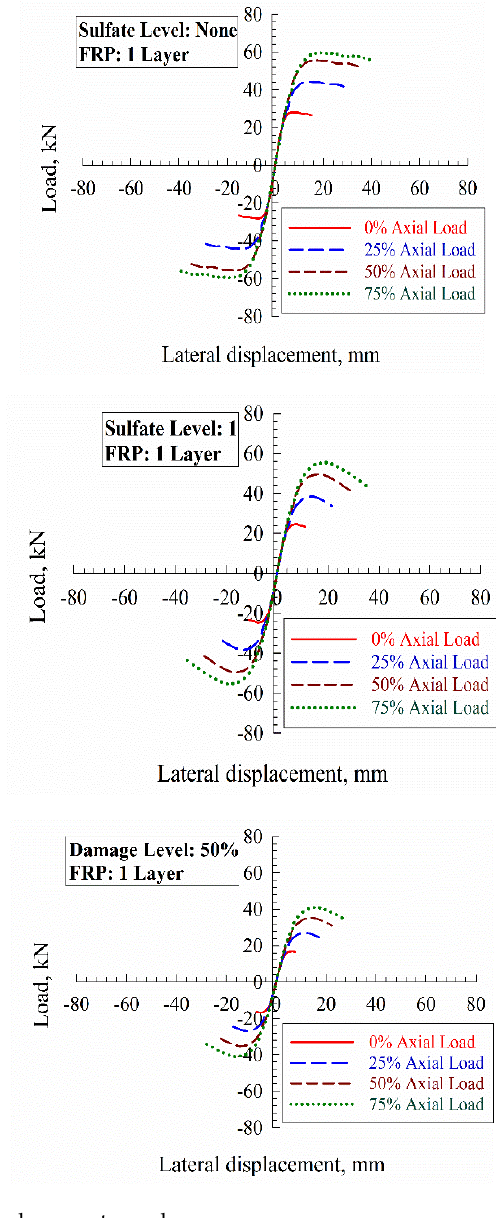
Figure 11. The load versus the lateral displacement envelopes. Moreover, it was observed that reinforcing elements with FRP had positively in- fluenced the horizontal loading and displacement capacities. The load was enhanced (normalized with respect to a joint with 0% axial loading) by 52%, 81%, and 89%, corre- sponding to axial loading levels of 25%, 50%, and 75%, respectively. On the other side, displacement was improved (normalized with respect to a joint with 0% axial loading) by 93%, 192%, and 250% under axial loads of 25%, 50%, and 75%, respectively. Furthermore, 0% damage decreased the load by 14.6% and displacement by 13.7%, at 25% damage, while 50% damage decreased the load by 30.2% and displacement by 22.9%. Further, FRP-strengthened joints have enhanced loading and displacement capacities (compared to the un-damaged joint sample): 104%, 83% at 0% damage level; 82%, 34% at 25% damage; and 52%, 23% at 50%